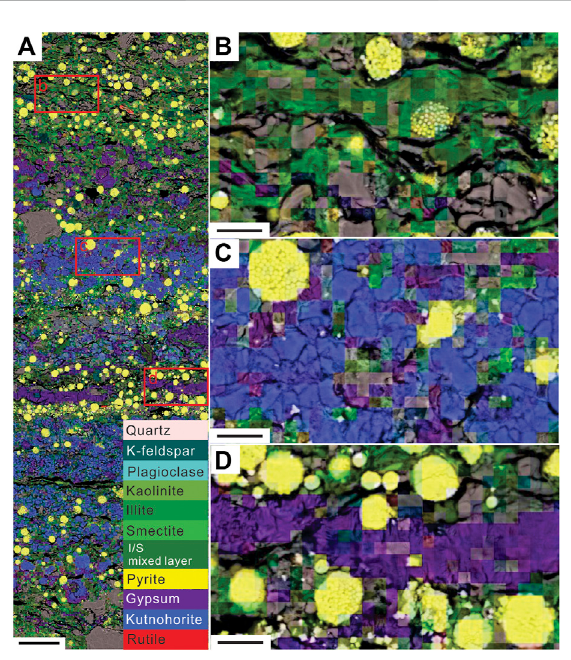
FIGURE 9 Representative petrographic images of laminated Permo- Carboniferous black shale from the Arckaringa Basin. Scale bars represent 50 μ m in (A) and 10 μ m in (B – D) . Sub-millimetre laminae record seasonal oscillations in water column redox conditions, consistent with a periglacial, silled basin depositional setting. The occurrence of kutnohorite represents a return from periodical oxygenation to anoxic condition, fi nally resulting in the deposition of laminae rich in organic matter and framboidal pyrite under fully anoxic conditions. Importantly, these samples did not show evidence for compositional variation or lamination in hand sample, highlighting the commonly erroneous assumption that mudrocks are homogeneous and compositionally invariant.